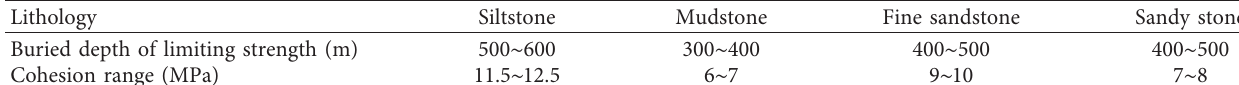
Figure 29: The pie chart of surrounding rock lithology. Table 5: Limiting strength and buried depth of rock.